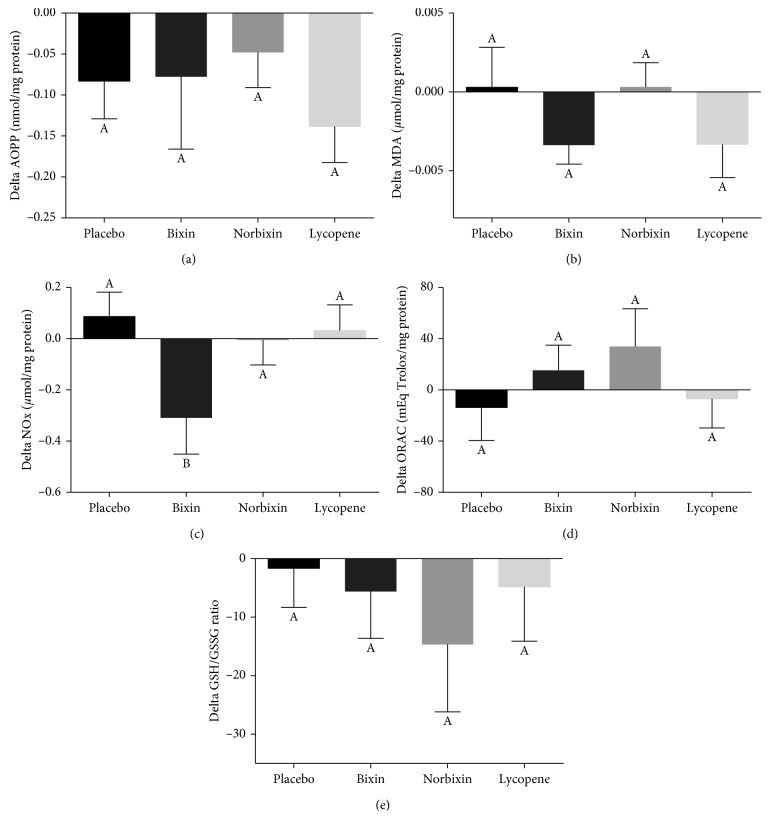
Effect of carotenoid supplementation on plasma protein (a) and lipid (b) oxidation, serum NOx levels (c), plasma antioxidant capacity (d), and red blood cells GSH/GSSG ratio (e). Results (mean ± SEM) are presented as the delta values between final and baseline values. Different letters indicate significant difference among treatments (p < 0.1). AOPP: advanced oxidation protein products; MDA: malondialdehyde; NOx: nitric oxide metabolites (nitrite and nitrate); ORAC: oxygen radical absorbance capacity; GSH: reduced glutathione; GSSG: oxidized glutathione.